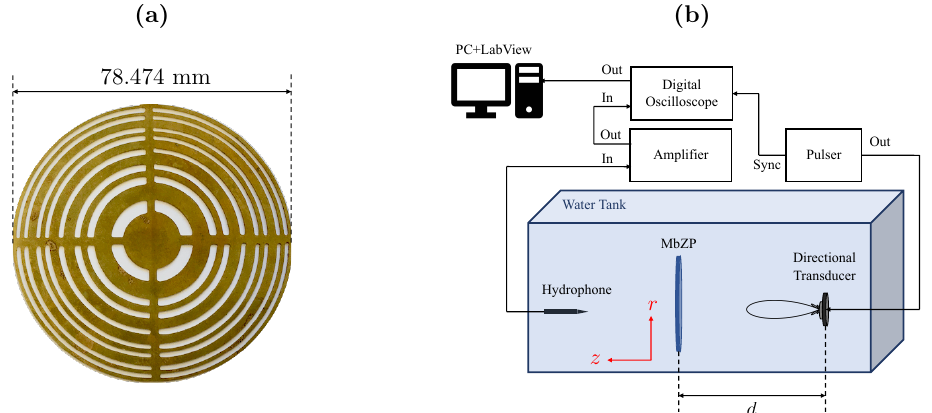
Figure 7. ( a ) Manufactured MbZP and ( b ) scheme of the experimental set-up.